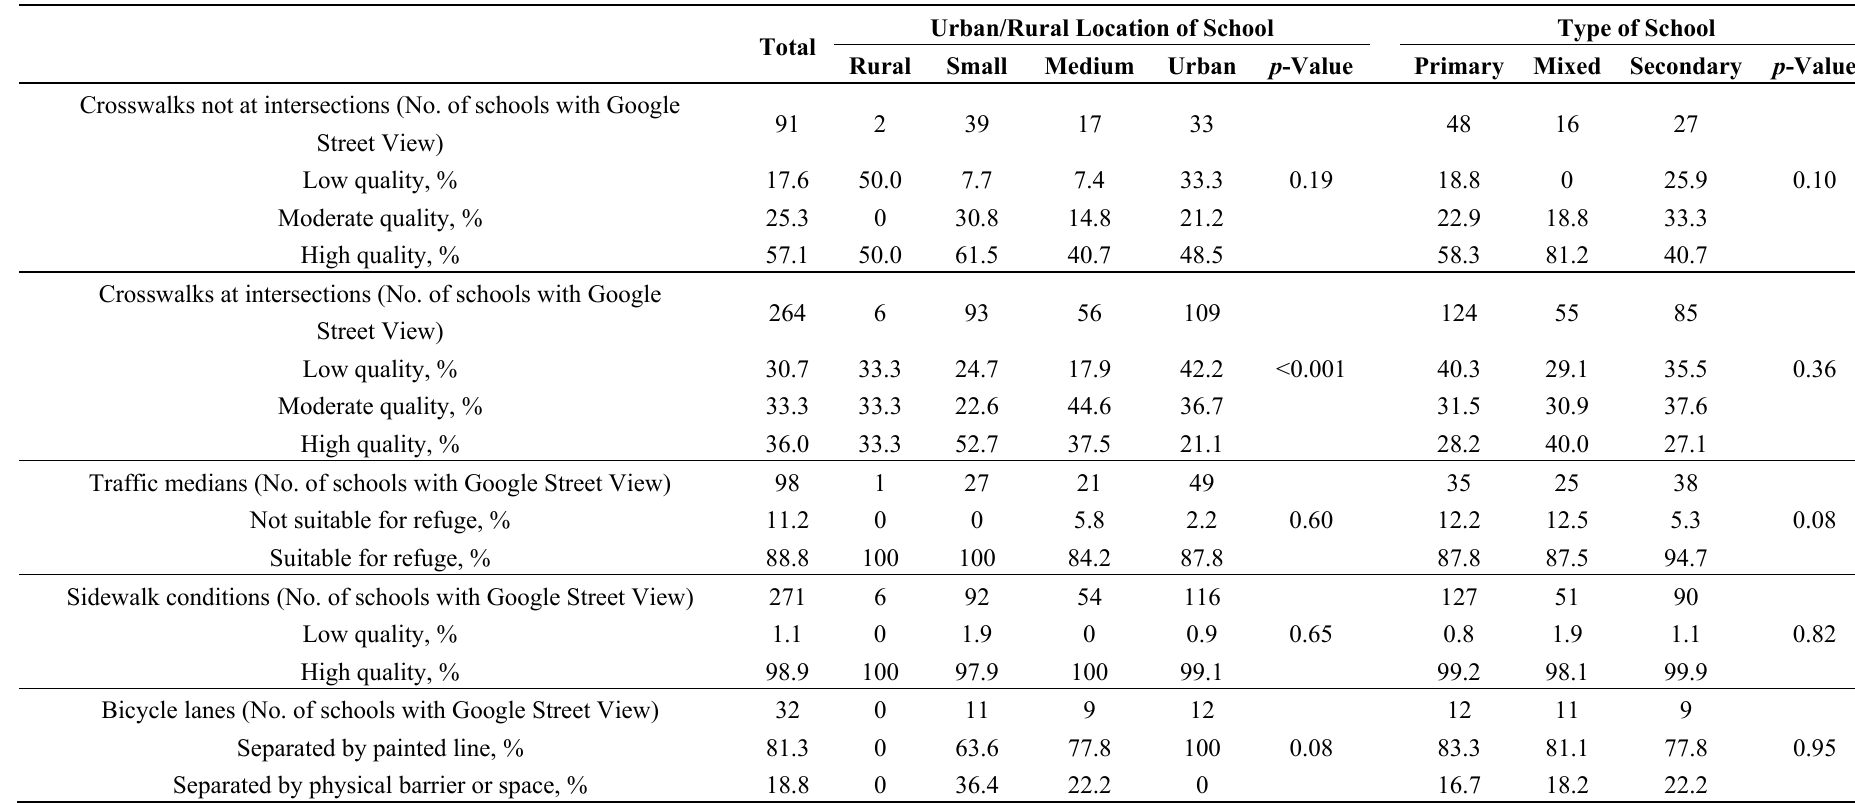
Table 2. Quality of pedestrian and cycling safety features in environments surrounding Canadian schools. Urban/Rural Location of School Type of School Total Rural Small Medium Urban p -Value Primary Mixed Secondary p -Value Street View)